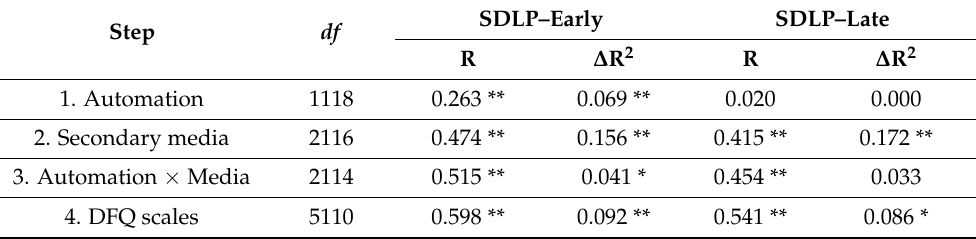
Table 8. Summary statistics for regressions of SDLP early and late on experimental factors and DFQ